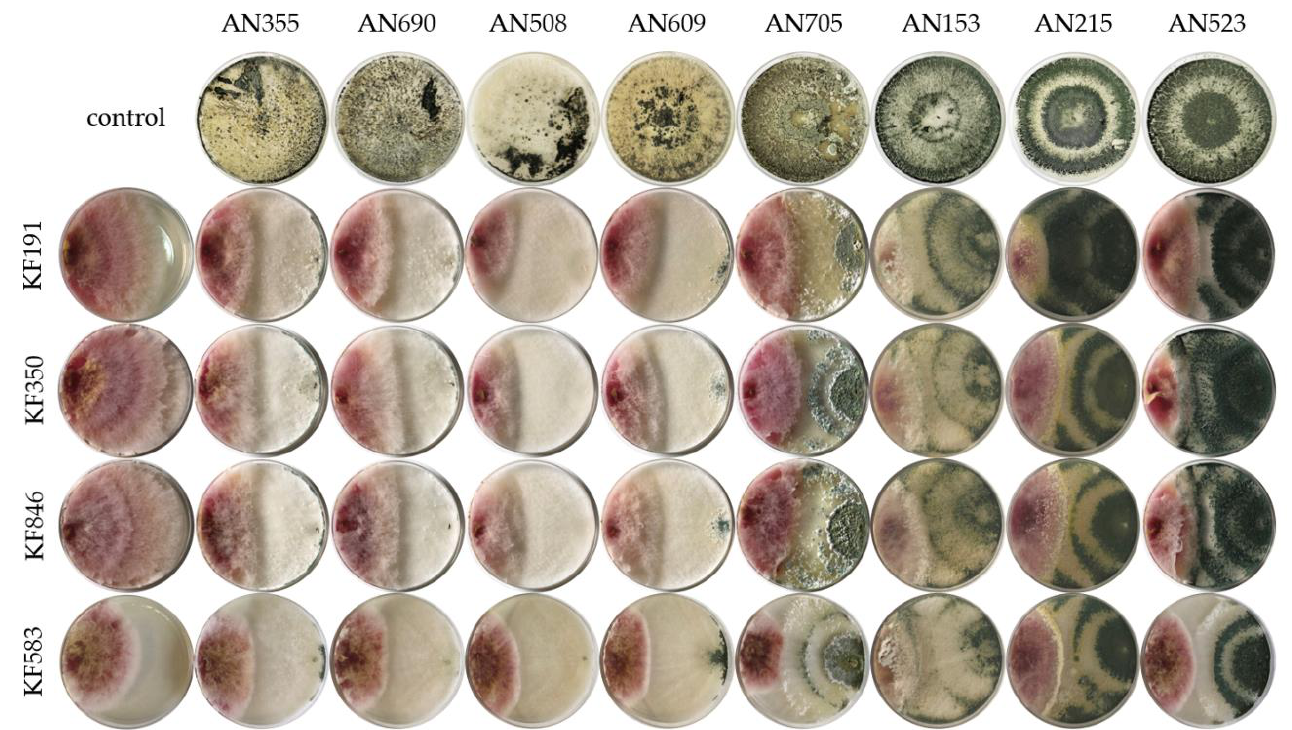
SD — standard deviation, the “ * ” symbol indicates a statistically significant result. SD—standard deviation, the “*” symbol indicates a statistically significant result.